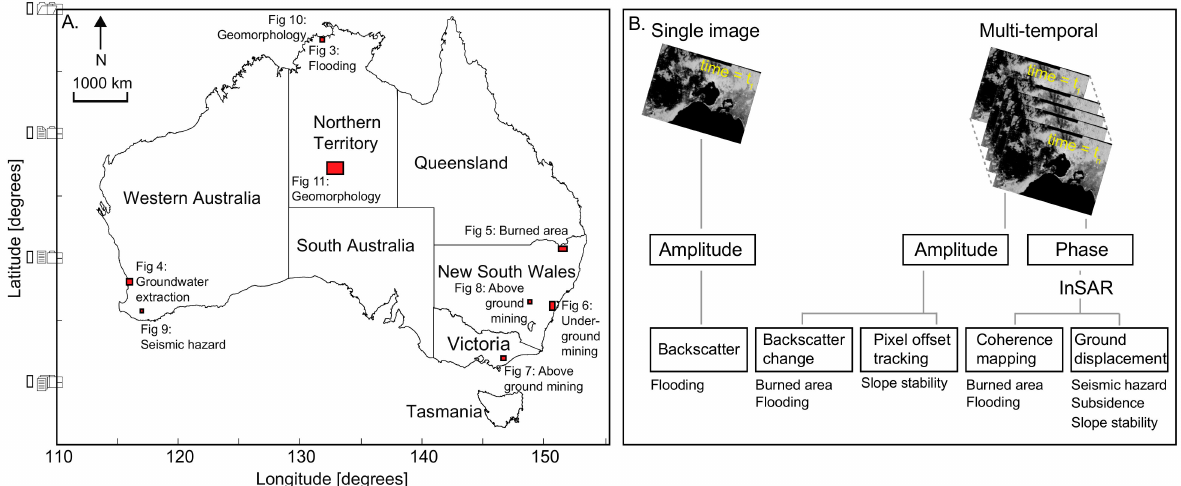
Figure 2. Uses of SAR amplitude and phase measurements for hazard monitoring in Australia. ( A ) Locations of the case studies and figures presented here. ( B ) Schematic showing approaches taken with SAR amplitude/phase data for hazard monitoring focusing on applications that are discussed in this study. Illustrative images are Sentinel-1 Interferometric Wideswath (IW) amplitude images acquired over Melbourne,